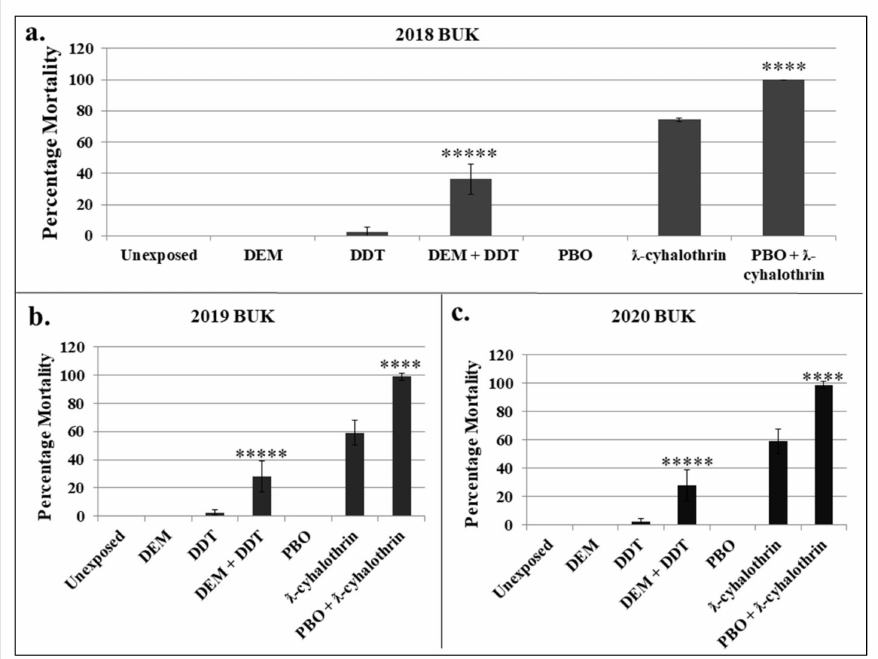
Figure 4. Investigation of the role of metabolic enzymes in insecticide resistance. ( a – c ). Effect of DEM and PBO synergists preexposure on susceptibility to DDT and ň -cyhalothrin, respectively, on BUK populations from 2018, 2019 and 2020. Results are average of percentage mortality for synergised and un-synergised females, with error bars indicating standard deviation. **** and ***** = significantly different at p < 0.0001 and p < 0.00001,